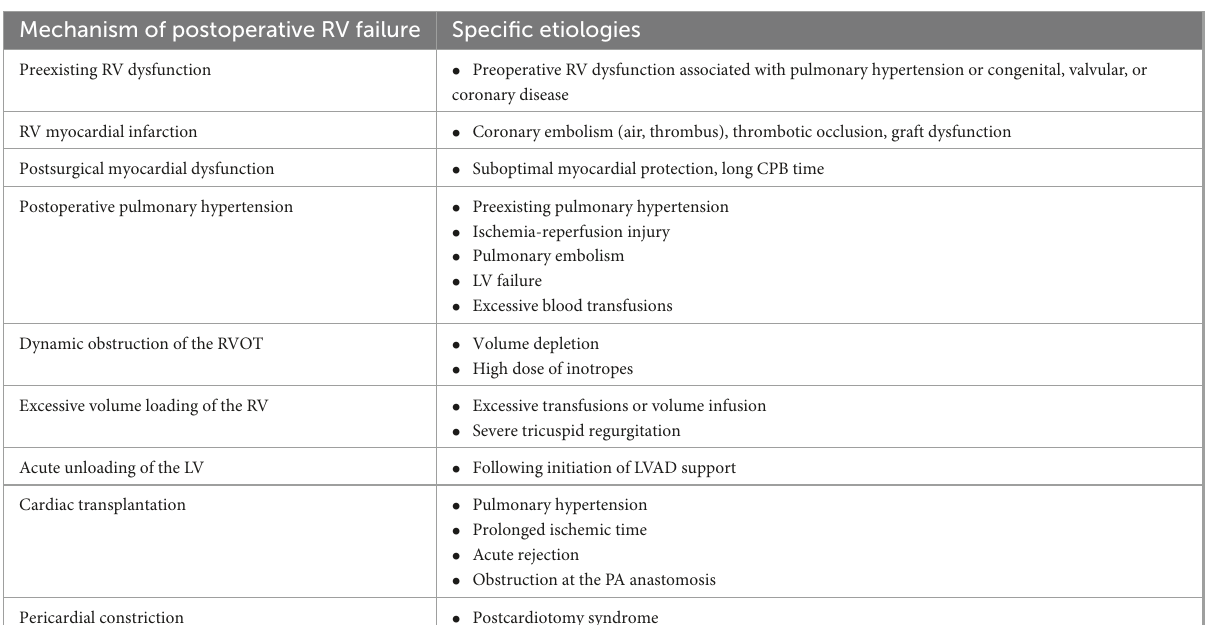
TABLE 1 Common causes of right ventricular failure in cardiac